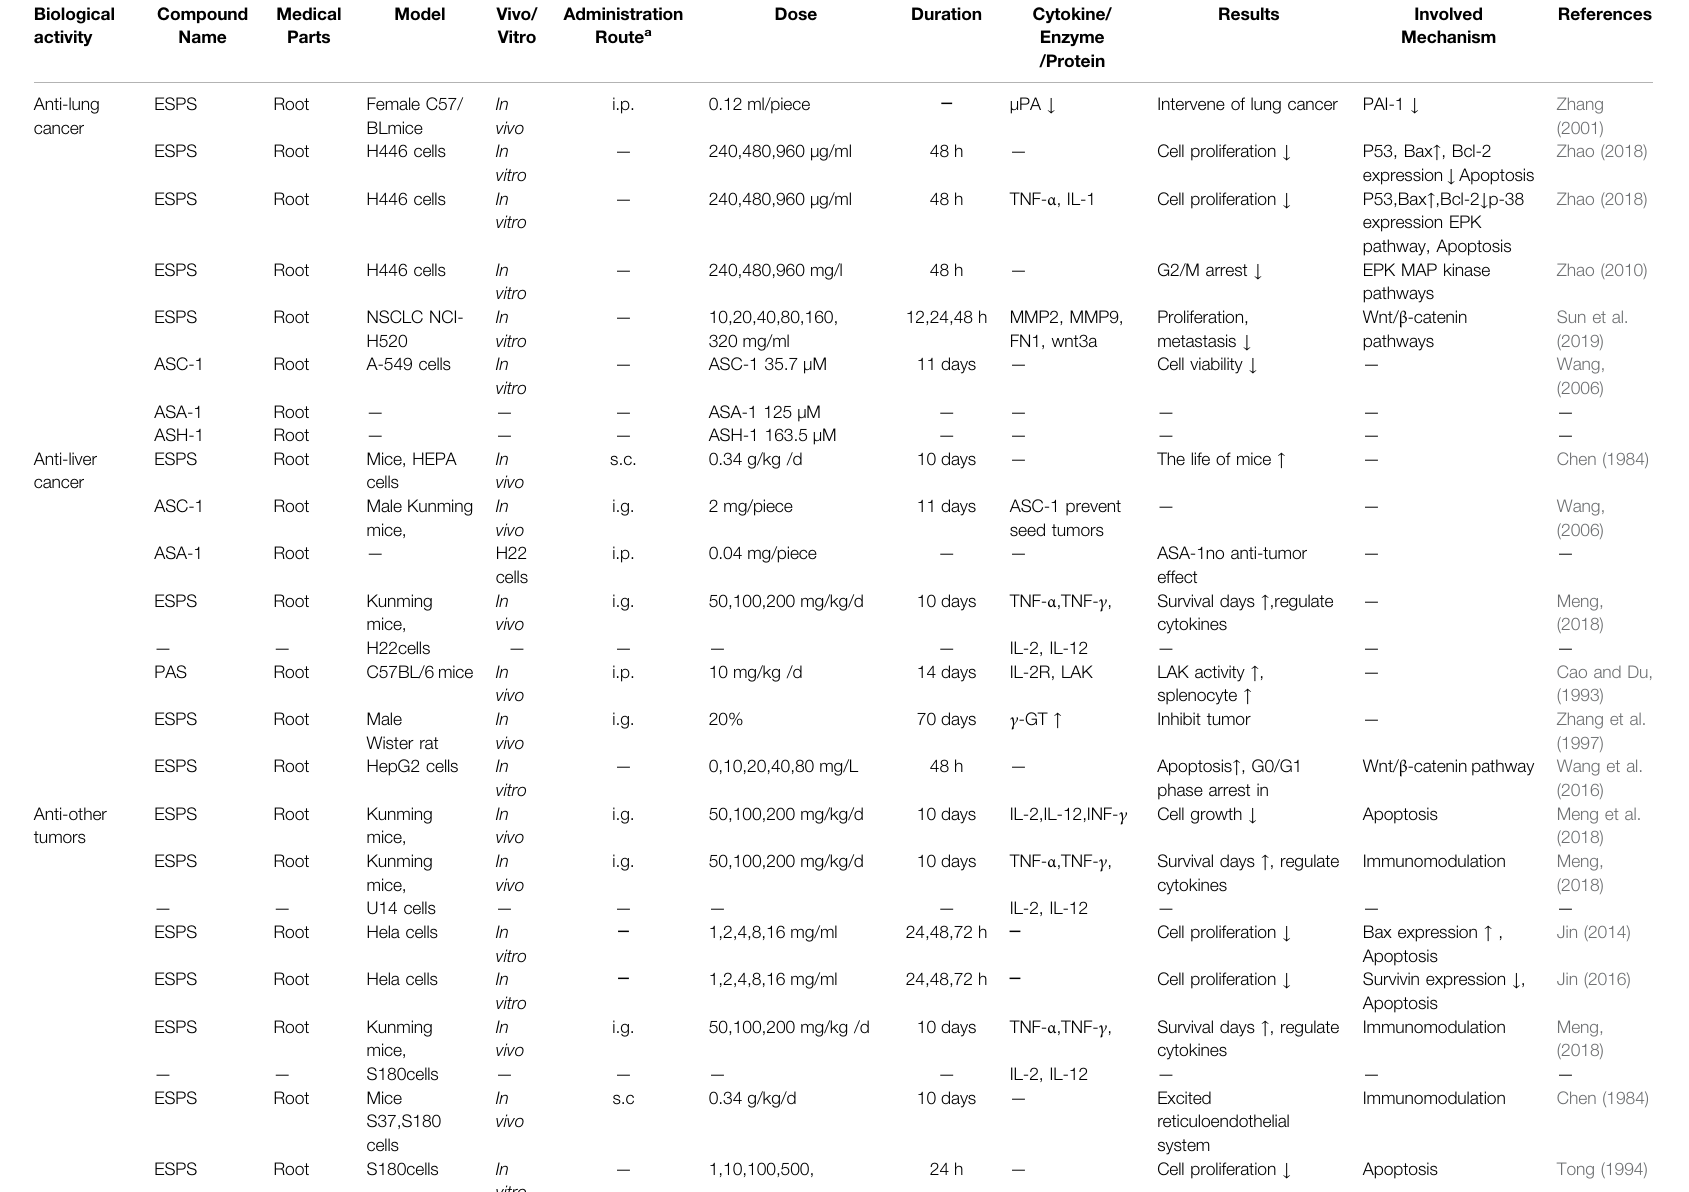
TABLE 3 | Pharmacological activities and involved mechanism of